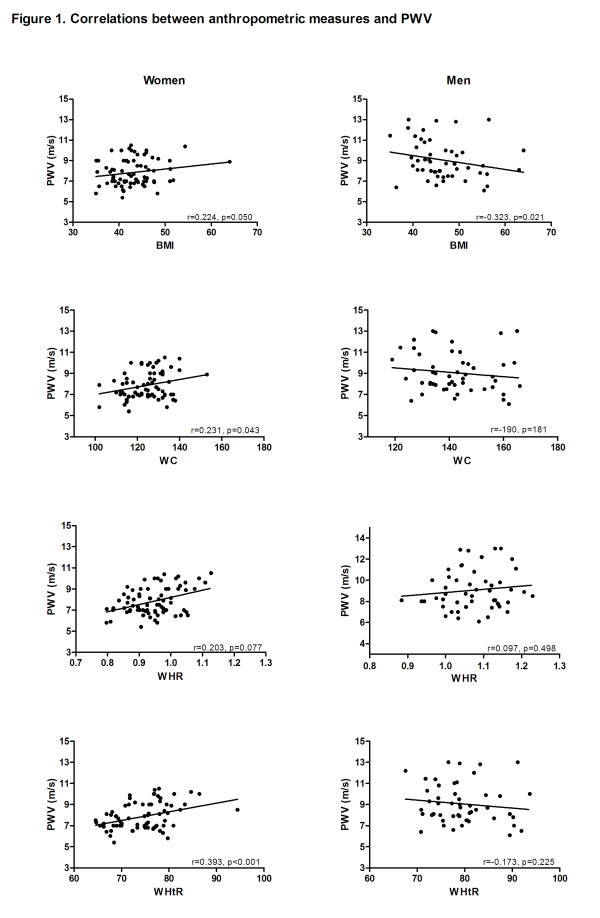
Correlations between anthropometric measures and PWV. The scatterplots show the relationship between anthropometric measures and PWV.